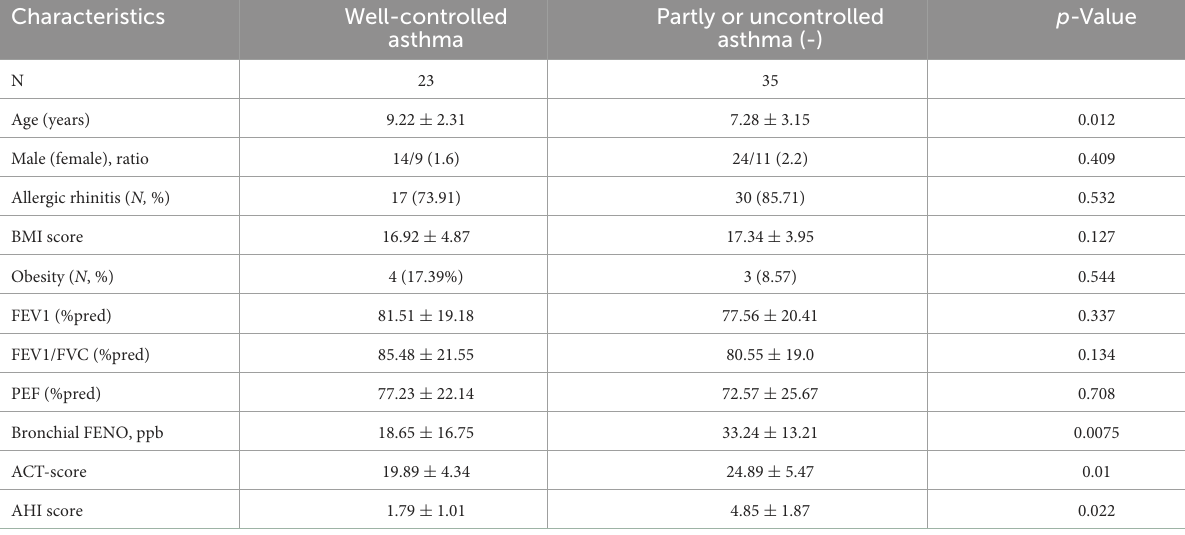
TABLE 3 Characteristics of the asthmatic group with OSA classified by asthma control status. Characteristics